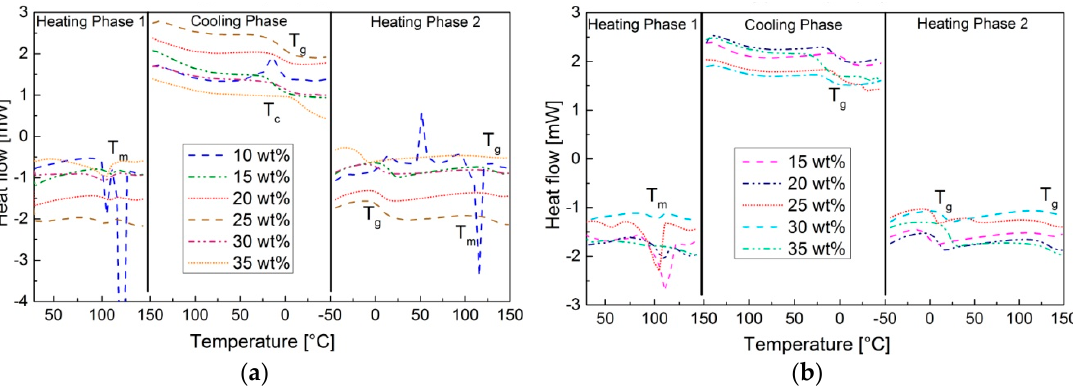
Figure 6. DSC-thermogram: ( a ) pS-DVB 10–35 ; ( b ) pS-DIB 15–35 . Representation of both heating steps and of the cooling step. Heating and cooling rate: 10 °C ∙ min − 1 .